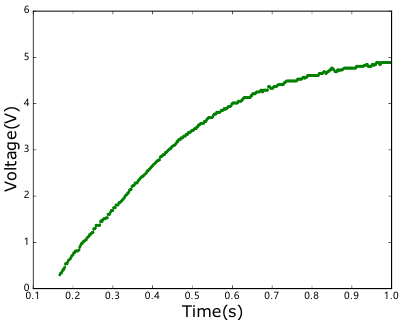
Figure 10. Wireless energy receiving process in a real device.